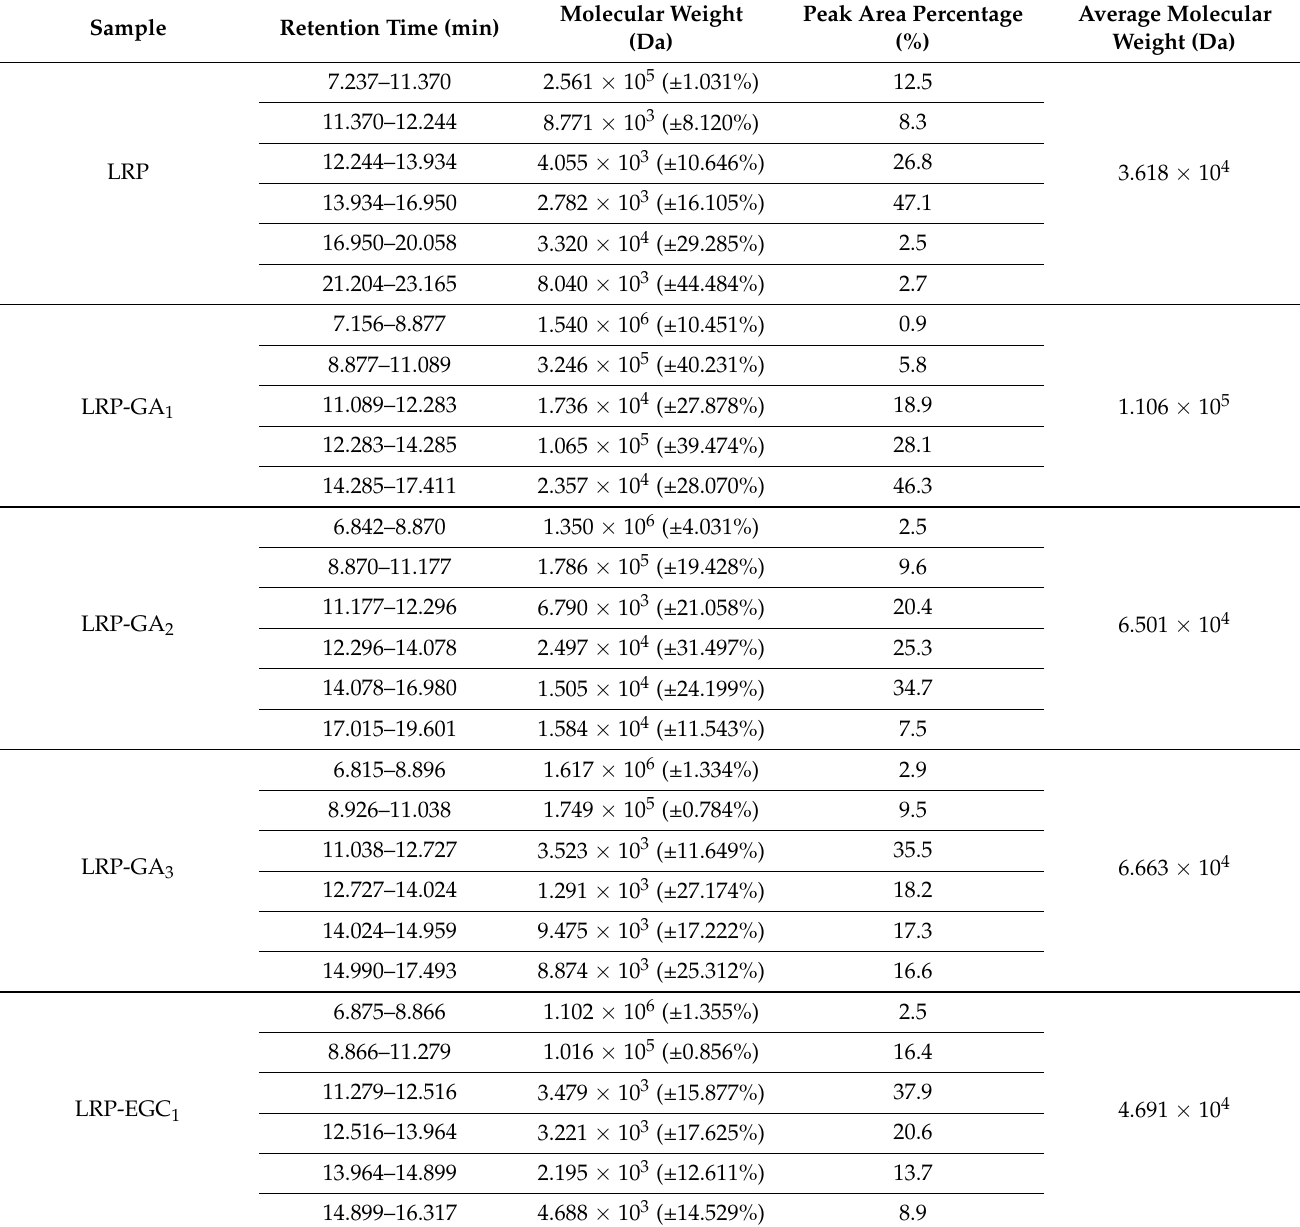
The molecular weights of LRPs and LRP-phenol complexes detected by the HPSEC − MALL − RI